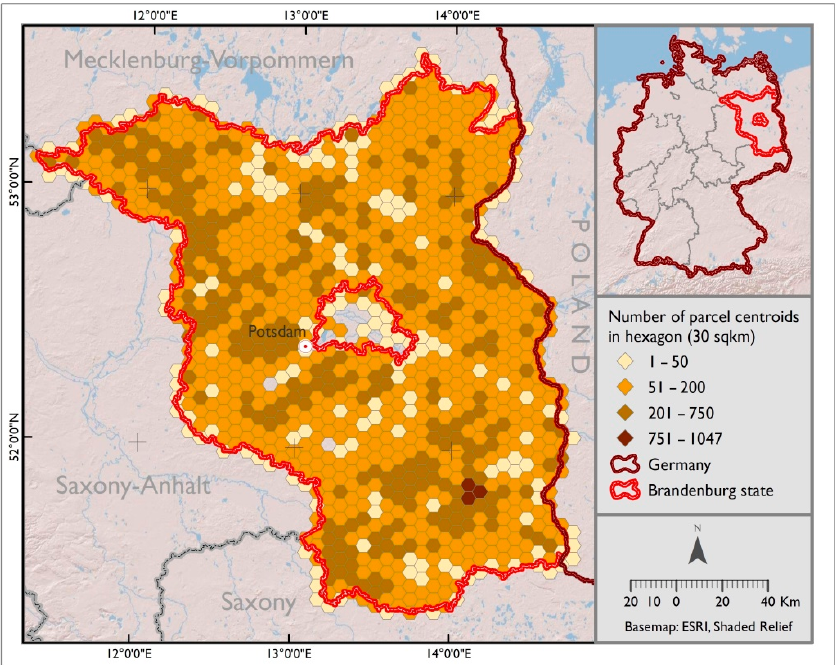
Figure 1. The study area Brandenburg with the density of agricultural parcels according to Land Parcel Identification System (LPIS) data for the year 2017.